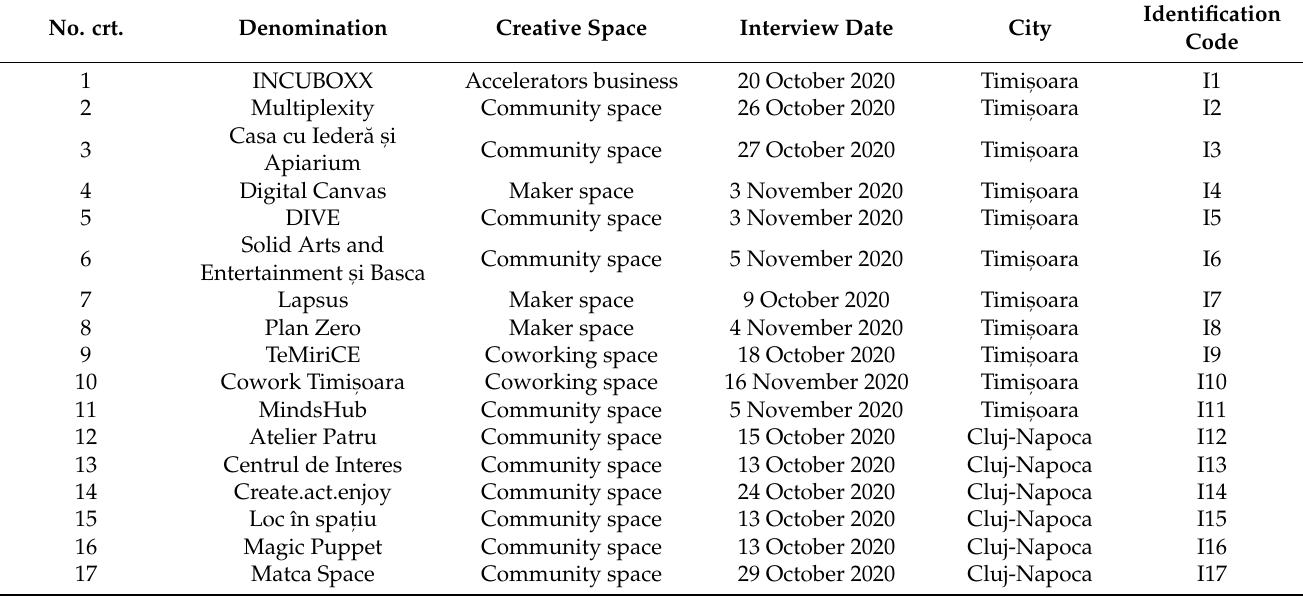
oara and Cluj-Napoca in which interviews were conducted. ,